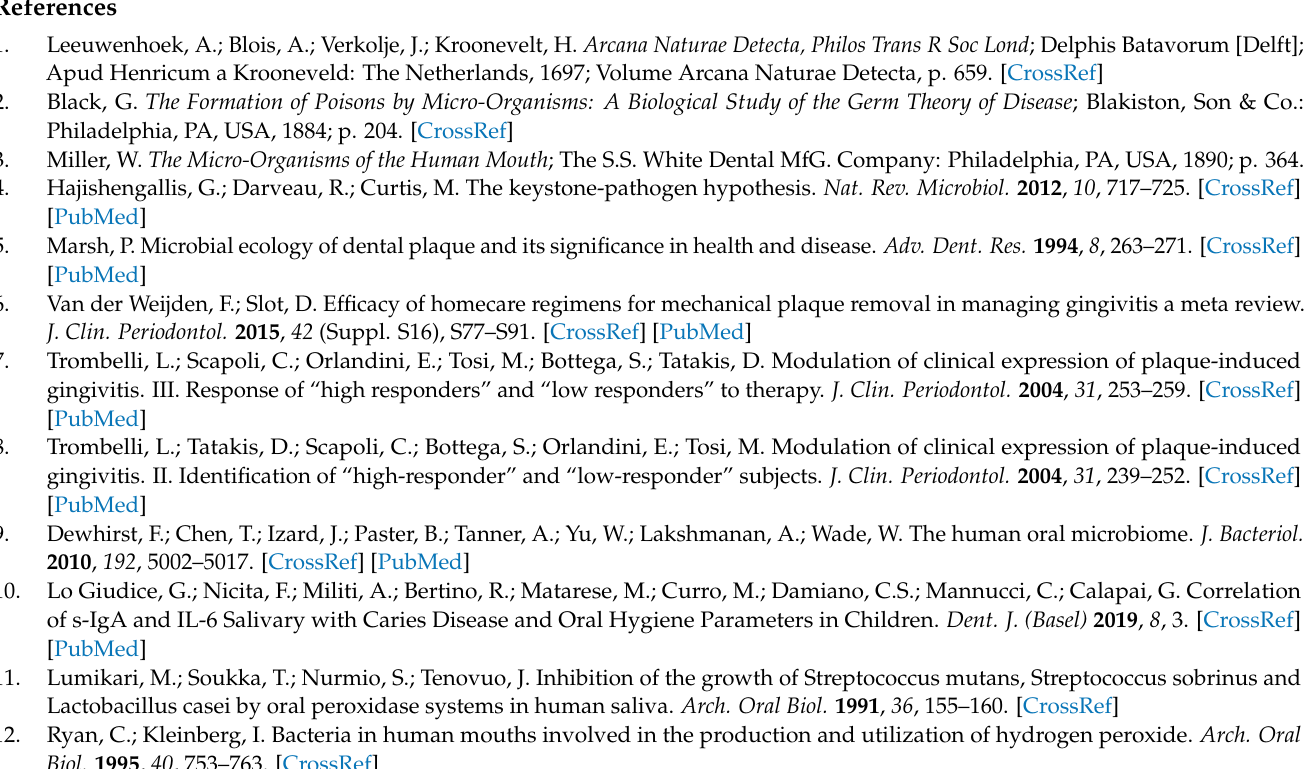
Table S1: Consort 2010 checklist of information to include when reporting a randomized trial. Table S2: Base Formulation of Enzyme-Containing